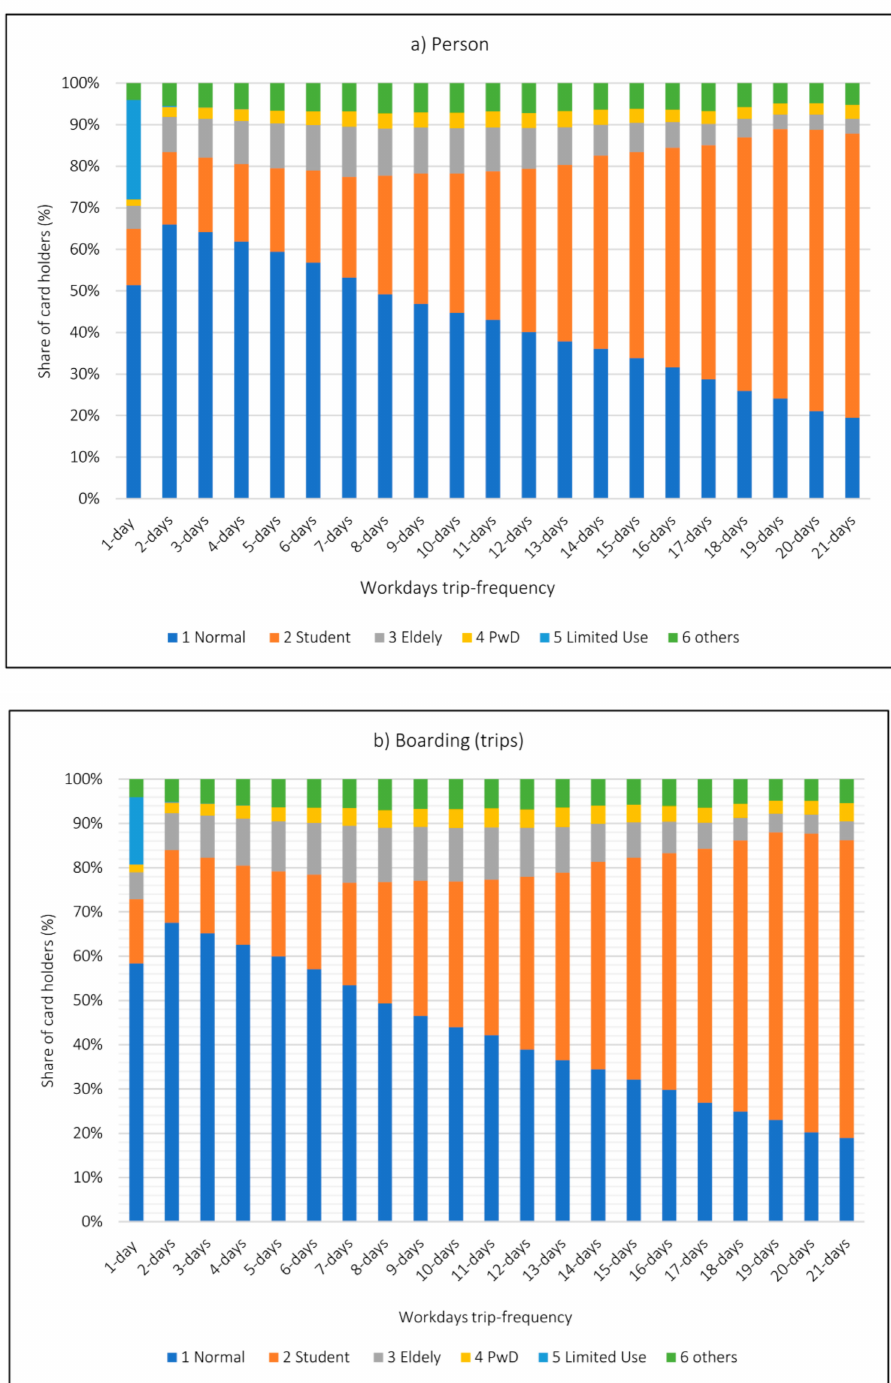
Figure 7. Share of different user groups on workdays in a month according to: ( a ) number of persons and ( b ) number of boardings in each user